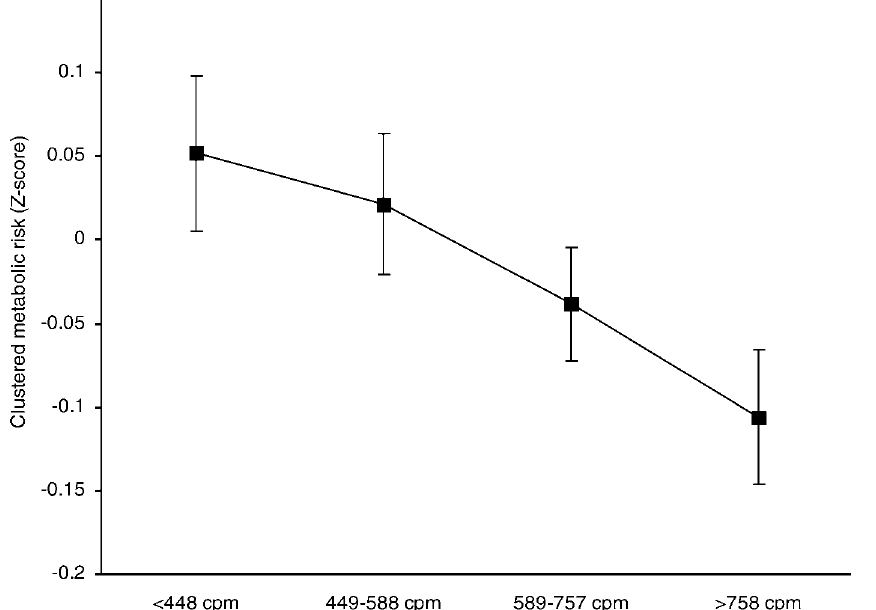
Figure 3. The Clustered Metabolic-Risk Score (Mean 95% CI) Stratified by Quartiles of PA ( n ¼ 1,485) Data on PA are adjusted for TV viewing, gender, study location, age group, sexual maturity, smoking status, birth weight, and parental SES ( p , 0.0001 in continuous